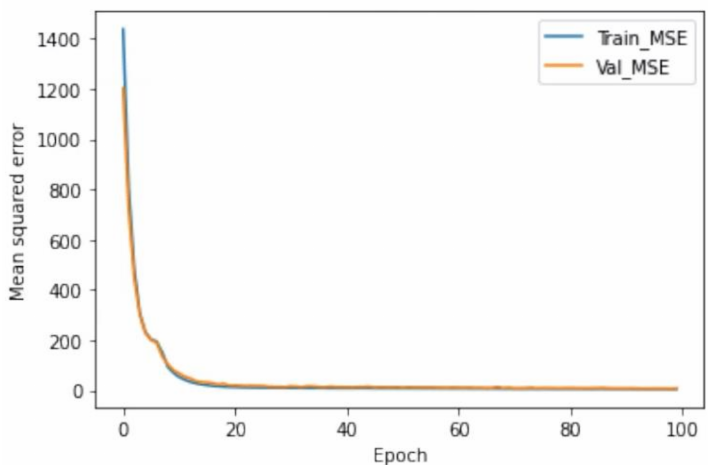
Figure 7. Training loss graph according to the size of the